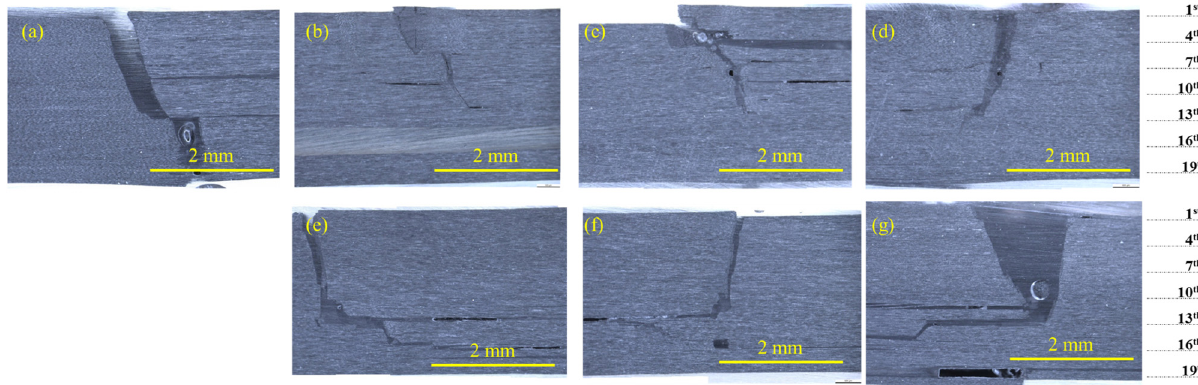
Figure 7: Cross - section observations on the flexural fracture behavior of CF/epoxy laminates with fiber breakage in different layers after bending tests: ( a ) original, ( b ) first layer, ( c ) fourth layer, ( d ) seventh layer, ( e ) 13th layer, ( f ) 16th layer, and ( g ) 19th